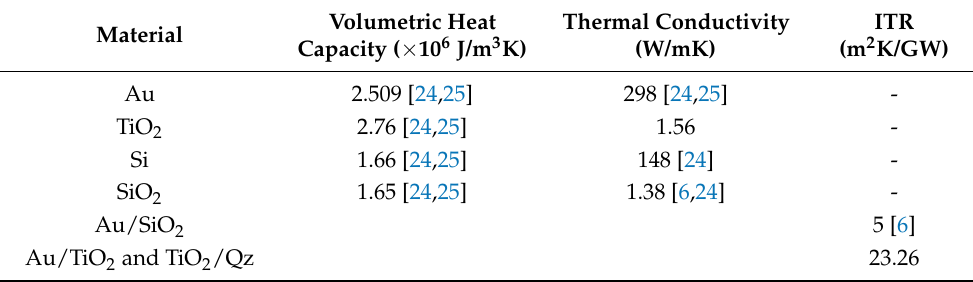
Table 2. Thermophysical properties of the materials used in the